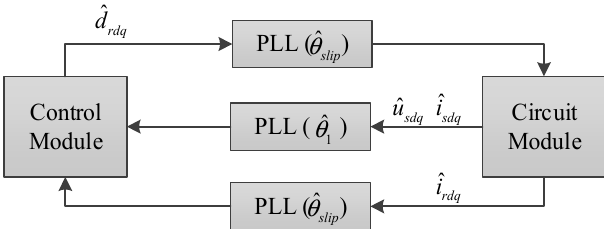
Figure 7. The angular transfer relationship between circuit module and control module on the rotor side.